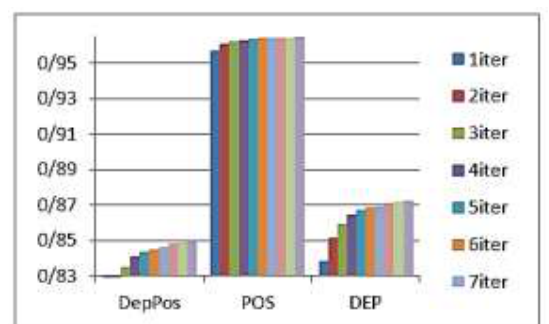
Figure 5. Study of relationship between iteration on Persian.